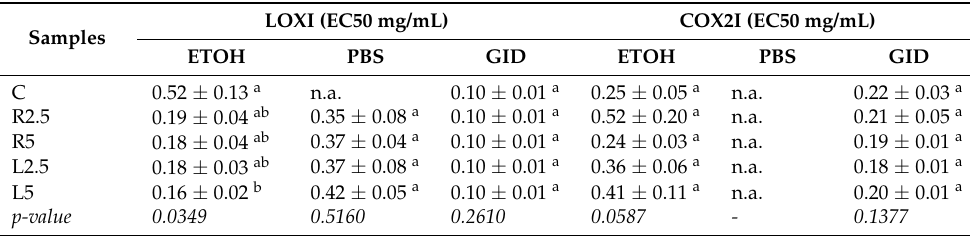
Table 5. Lipoxygenase and cyclooxygenase-2 inhibitory activity of extracts from pasta supplemented with dried Reishi and Lion’s Mane